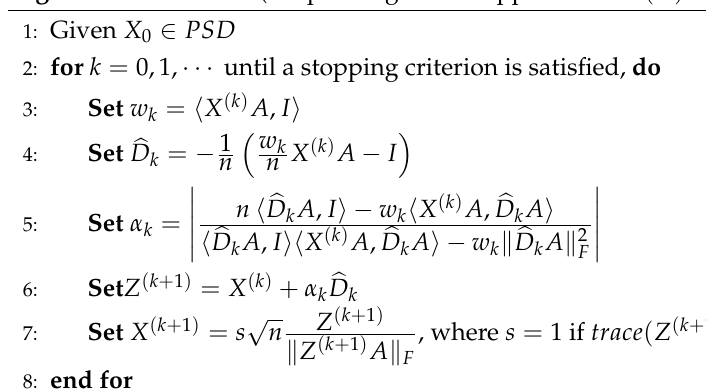
Algorithm 2 : MinCos (simplified gradient approach on F ( X ) = 1